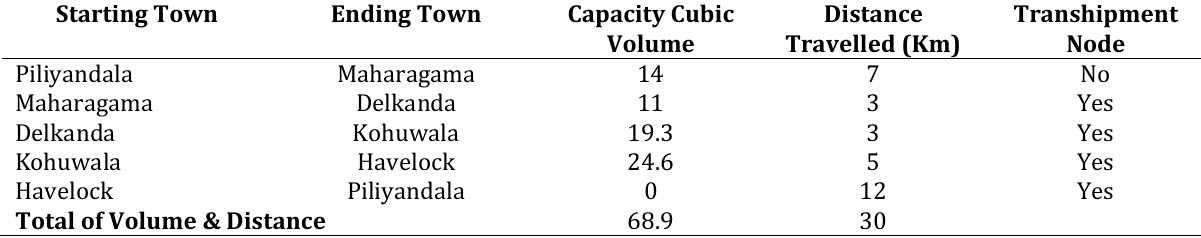
Table 2: Starting and ending nodes of cluster 01- piliyandala depot Starting Town